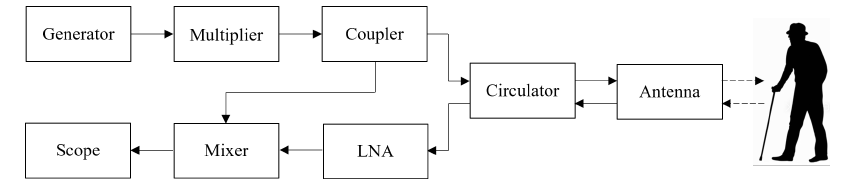
Figure 4. Scheme of the CW micro-Doppler radar.